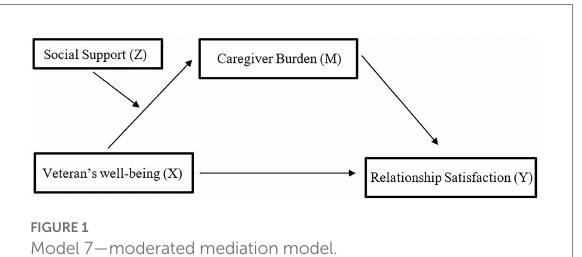
FIGURE 1 Model 7—moderated mediation